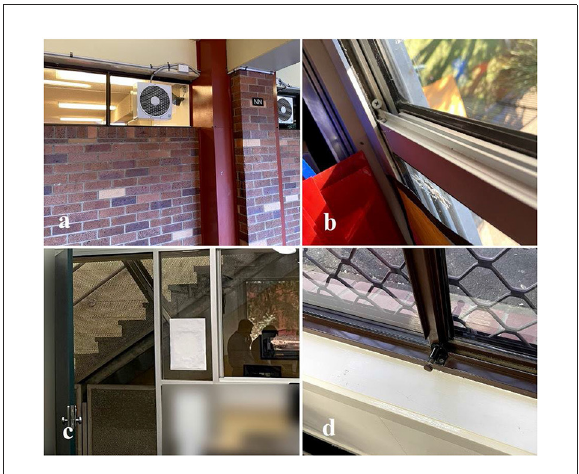
FIGURE6 Four examples of human factors affecting ventilation (a–d) , described in text below.